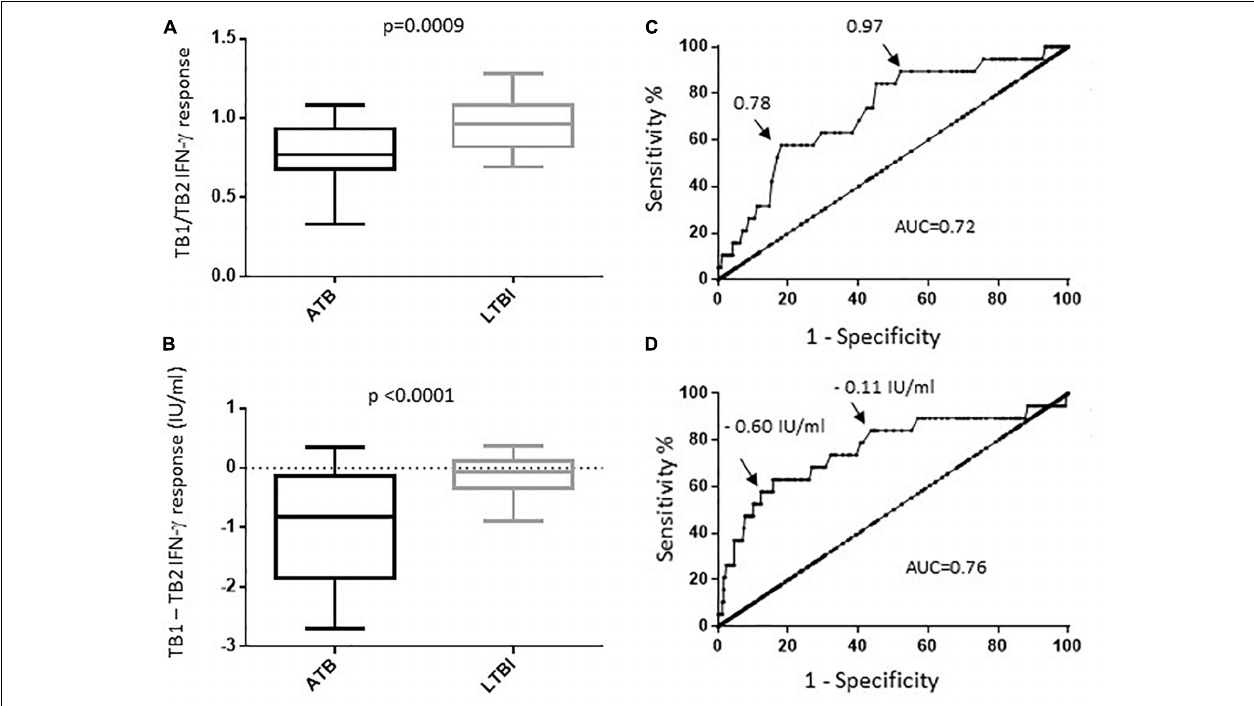
FIGURE 2 | Comparison of IFN- γ response in QTF tube 1 versus tube 2. Tube 1 (TB1) contain ESAT6 and CFP10 peptides designed to stimulated TB specific CD4 + and CD8 + T cell mediated responses. (A) Ratio of TB1/TB2 IFN- γ response. The median, IQR, 10th and 90th are shown in boxplots for each group. (B) Difference of the IFN- γ response in TB1 minus TB2 in ATB and LTBI. The median, IQR, 10th and 90th are shown in boxplots for each group. (C) ROC curve for TB1/TB2 IFN- γ response in differentiating ATB and LTBI. (D) ROC curve for TB1 minus TB2 IFN- γ response in differentiating ATB and LTBI. The AUC and tradeoff values are indicated on the ROC